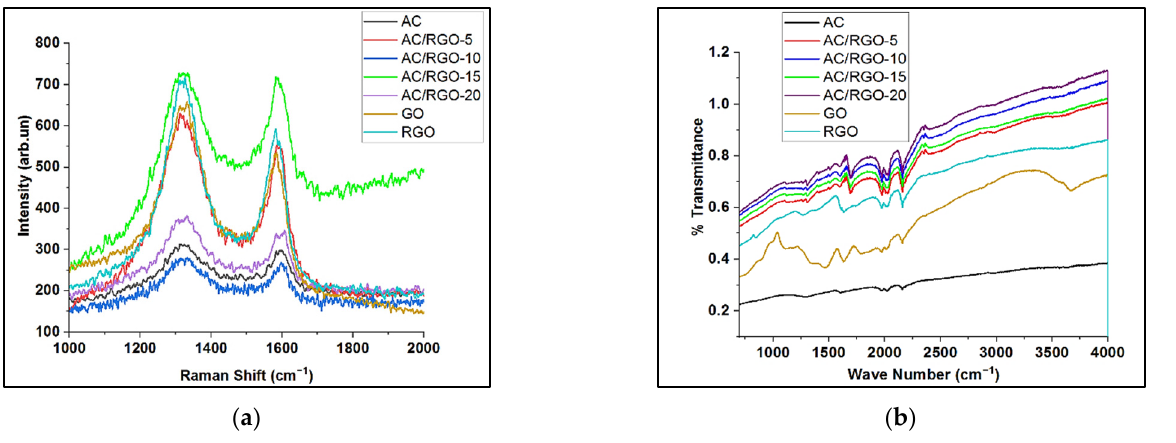
Figure 3. ( a ) Raman spectra of precursors and AC/RGO-x composites; ( b ) FTIR spectra of precursors and AC/RGO-x (where x = 5, 10, 15, and 20 wt% RGO) composite electrodes.